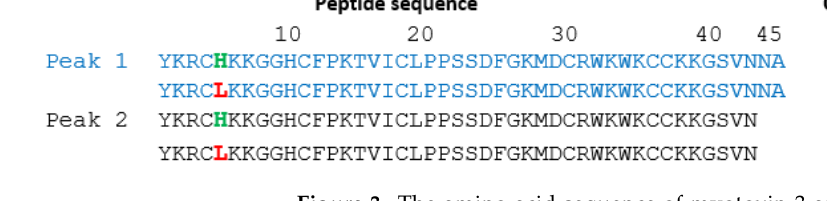
Figure 4. The a mino acid sequence of myotoxin-3 and its isoforms. The amino acid sequence of peptides from peak 1 (blue) and peak 2 (black) with calculated (ProtParam tool) and experimental masses. Residues in position 5 residues are highlighted in bold. Myotoxin-3 corresponds to the first peptide (UniProt database accession number P63176).